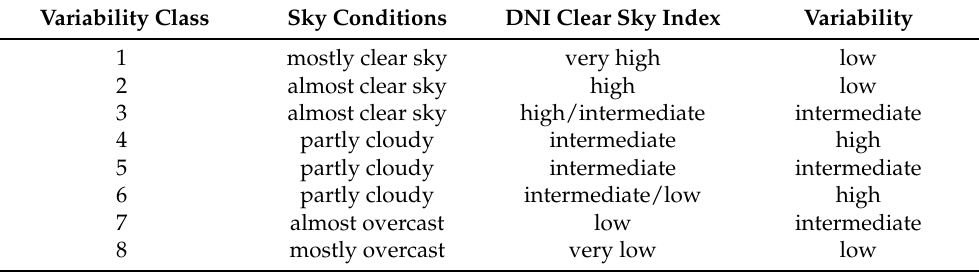
are indicated by each of the eight DNI variability classes. These classes are defined and calculated according to Nouri et al. [40]. The table was created based on